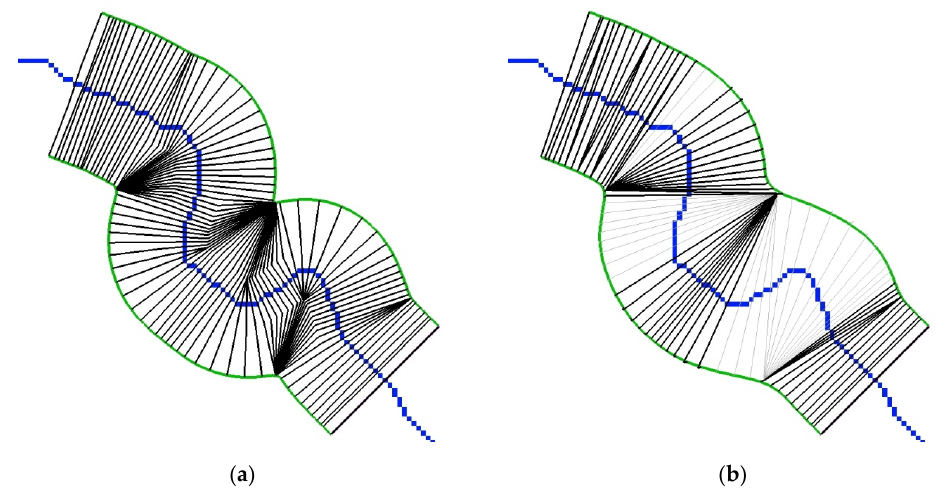
Figure 34. Two sets of extracted cross-sections with: ( a ) non planar; and ( b ) planar cross-sections.